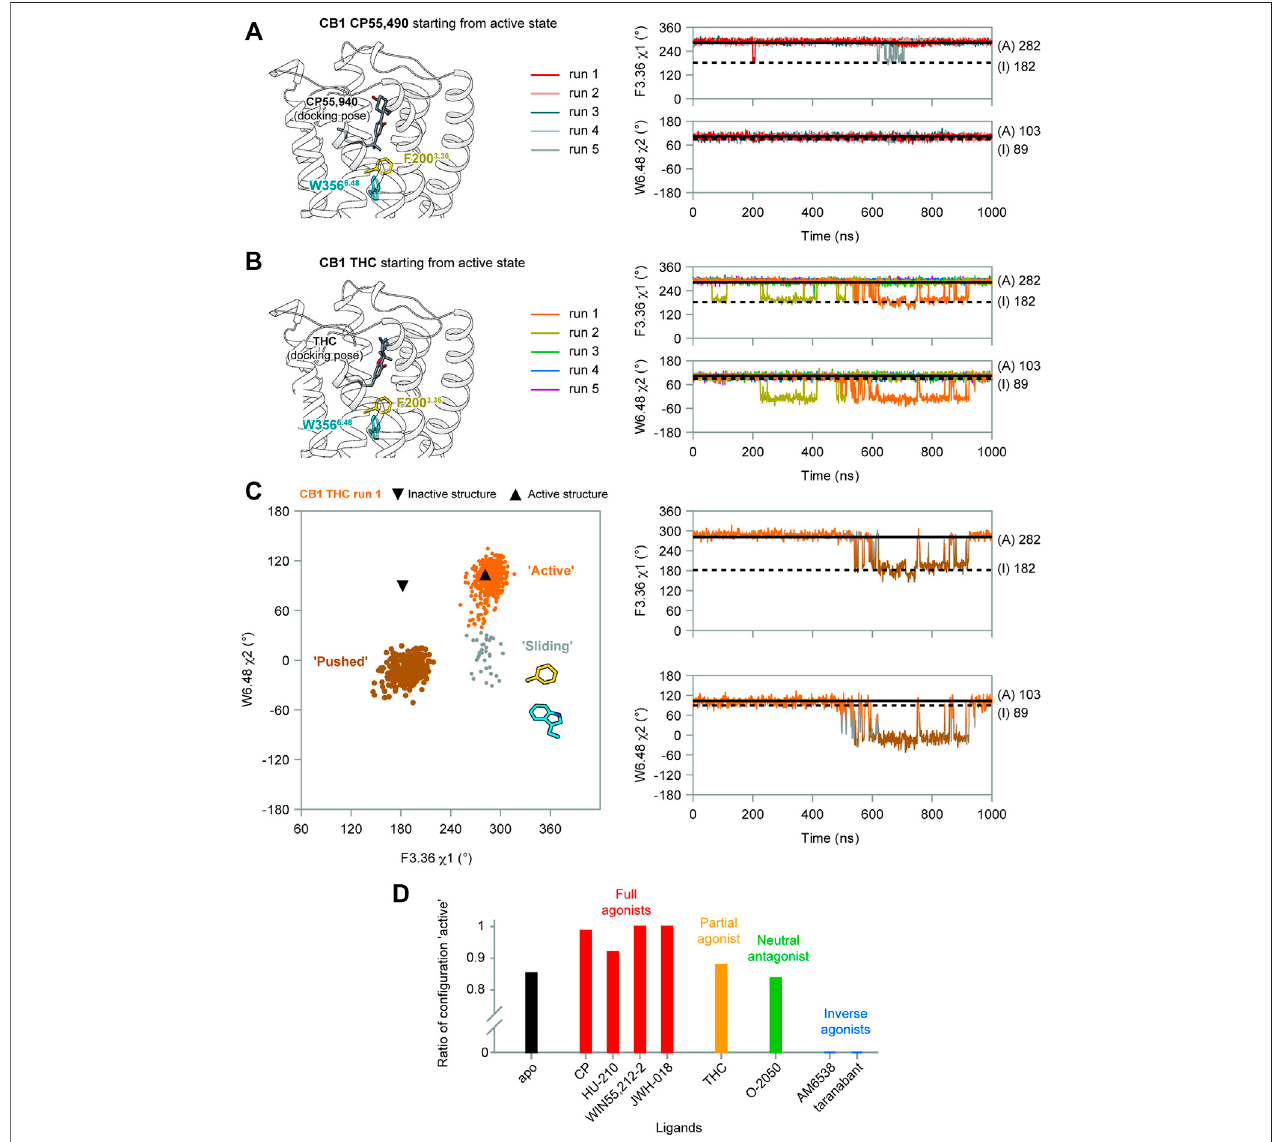
FIGURE 4 | F200 3.36 /W356 6.48 side-chain conformations during MD simulations of CB1 bound with CP55,940 and THC. (A) In CP55,940-bound CB1, F200 3.36 andW356 6.48 side-chainsgenerallyremainedstableduringsimulations. (B) THC-boundCB1showed fl uctuationsofF200 3.36 andW356 6.48 side-chainsinruns1 – 2. (C) Movements of F200 3.36 and W356 6.48 in THC-bound CB1 run 1 (results for run 2 are shown in Supplementary Figure S4A ). Left panel: distribution of dihedral angles showed a new con fi guration of F200 3.36 /W356 6.48 . Right panel: F200 3.36 χ 1 and W356 6.48 χ 2 during simulation. (D) The ratio of con fi guration “ active ” in all the simulations of CB1 bound to each ligand, showing the correlation with ligand ef fi